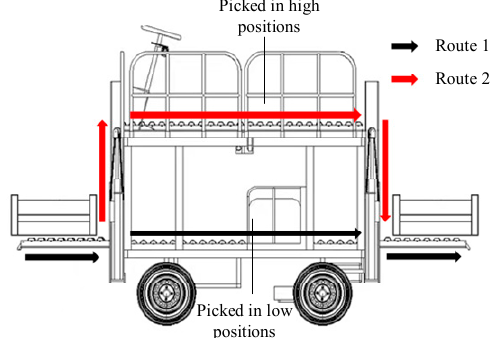
Figure 3. Fruit box transportation